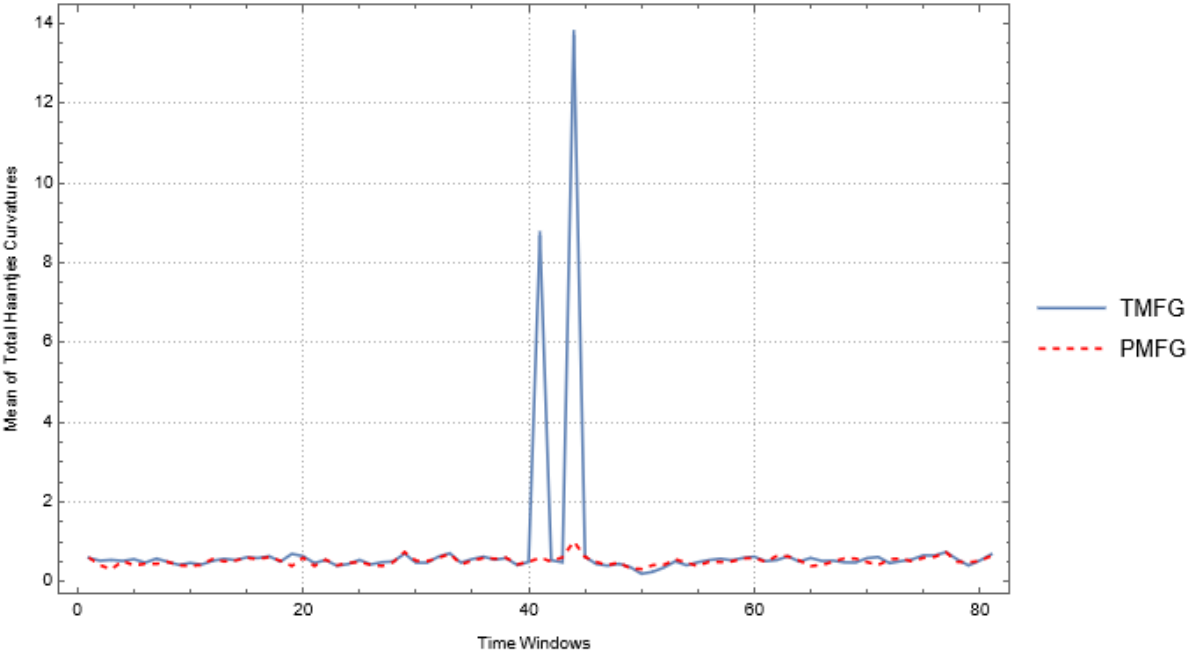
Figure 7. Means of total Haantjes curvatures of VDG of 𝐺 (cid:3021)(cid:3037) for BIST using TMFG and PMFG filtra- tions.